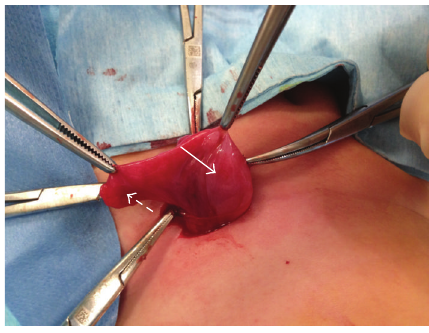
Figure 2: Intraoperative findings. Hernia sac containing uterus, fallopian tube, and